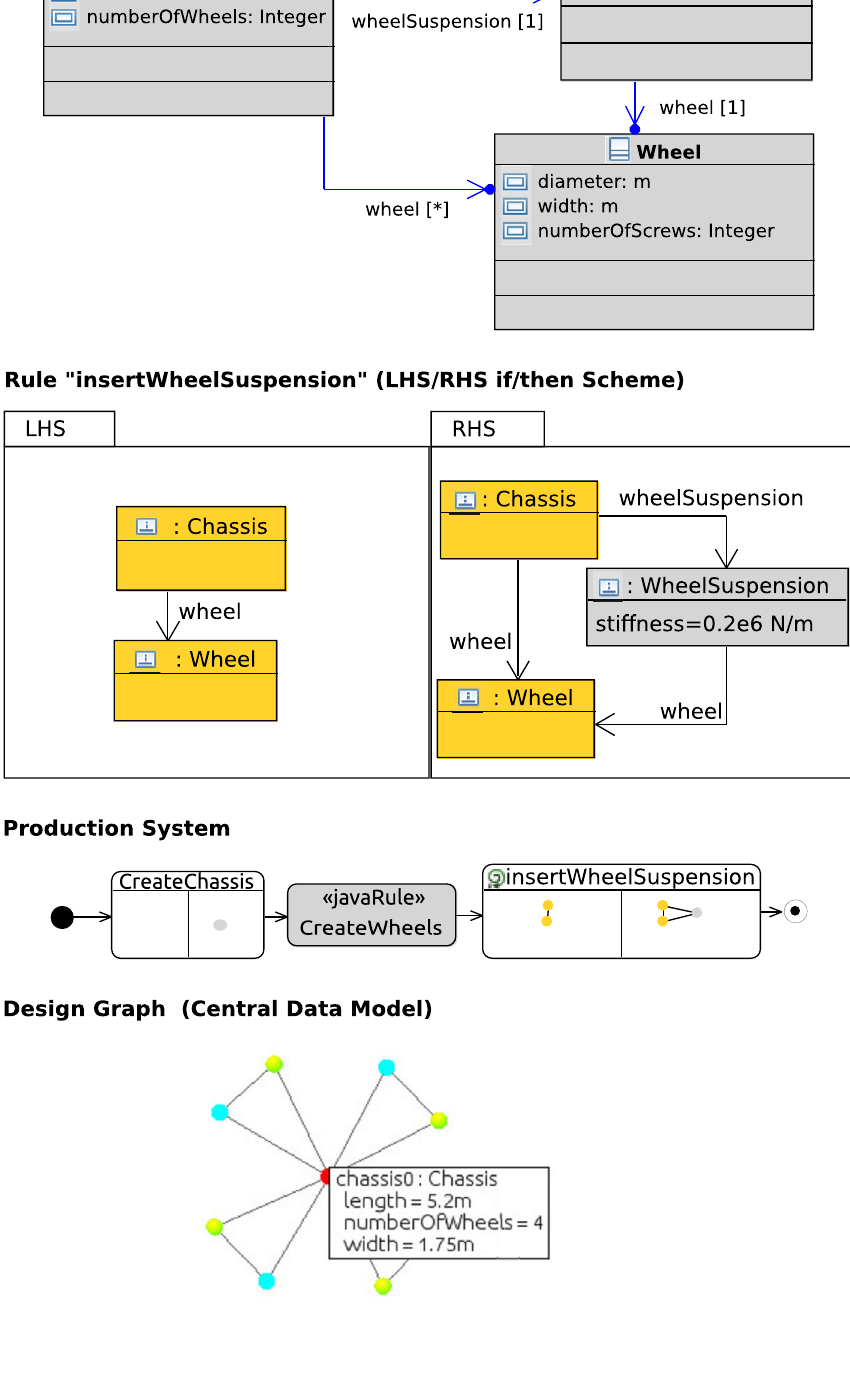
Fig. 3 Schematic design language of a simplified car